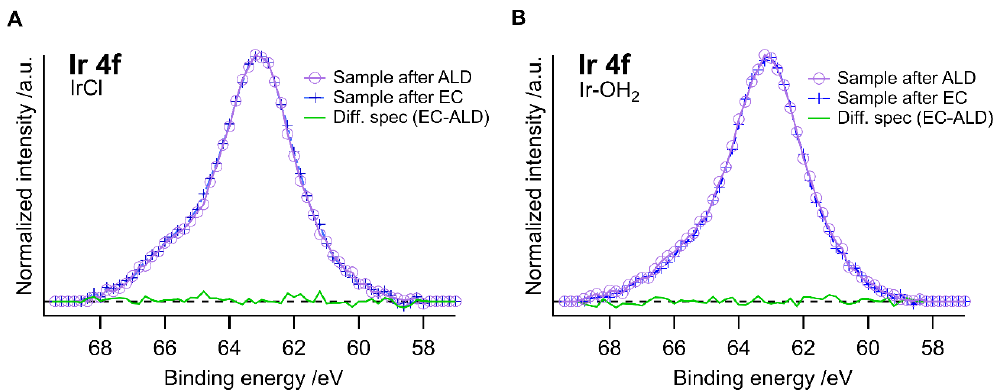
Figure 5. Proposed hydrolytic ( A ) and Cp* ligand oxidation ( B ) mechanisms for (re)generation of the active Ir – OH 2 catalyst under operating conditions, which had undergone deactivation during the deposition of the ALD-TiO 2 layer.